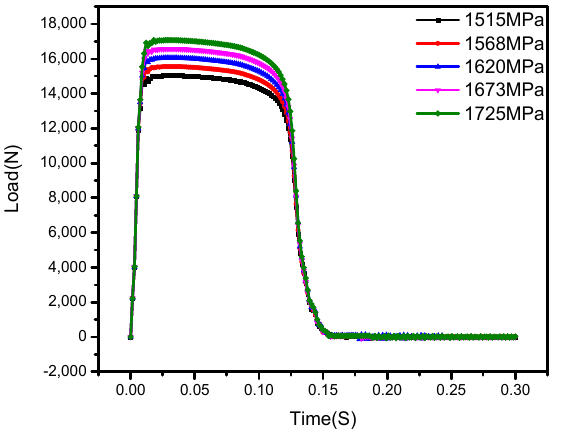
Figure 11. Tensile loads under different tensile strengths with a notch bottom diameter of 2.8 mm.